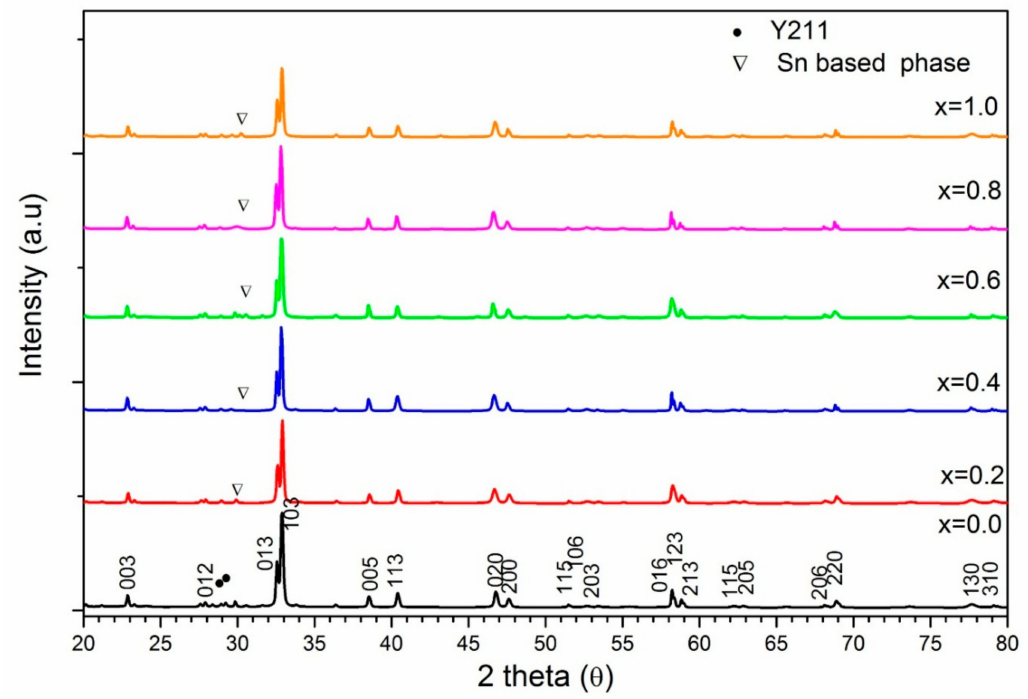
Figure 1. XRD diffractograms of Y-123 with x = 0.0, 0.2, 0.4, 0.6, 0.8, and 1.0 wt.% SnO 2